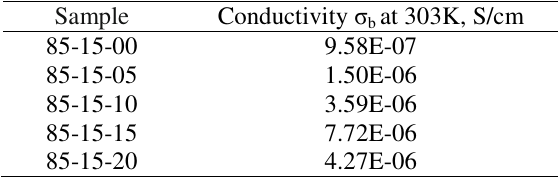
Cl + x wt % of TiO 4